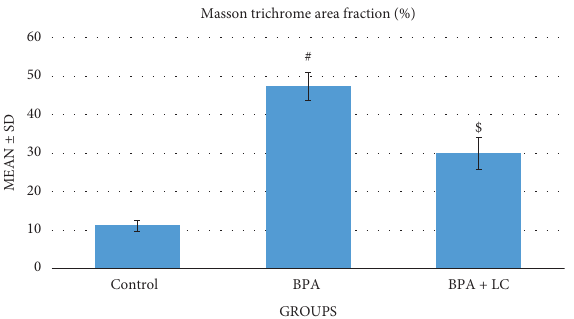
Figure 5: Graph demonstrating the quantitative analysis of interstitial collagen fber area percentage in the heart. Data are expressed as means ± SDs. # : signifcantly diferent from the control group, while $ signifcantly diferent from the BPA group ( P < 0 .